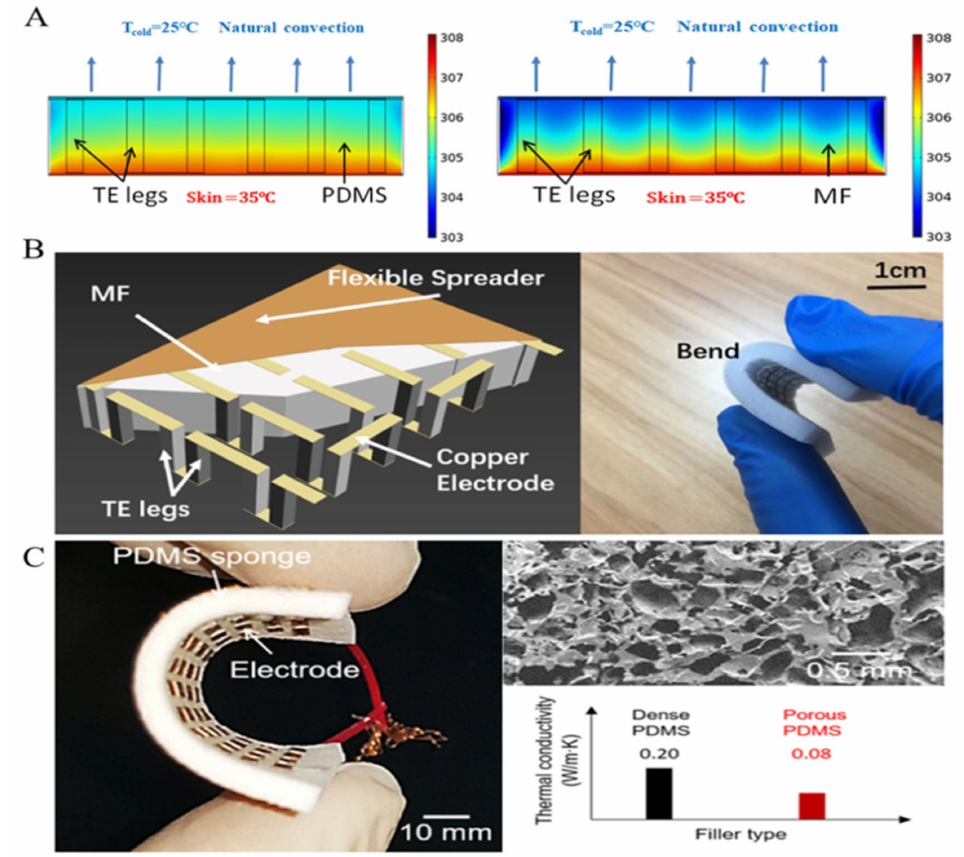
Figure 10. ( A )The internal temperature distributions of the TEG filled with PDMS and MF [64]. ( B ) Schematic of the WTEG filled with MF [64]. ( C ) Schematic of the WTEG filled with porous and thermal conductivity of PDMS and porous PDMS